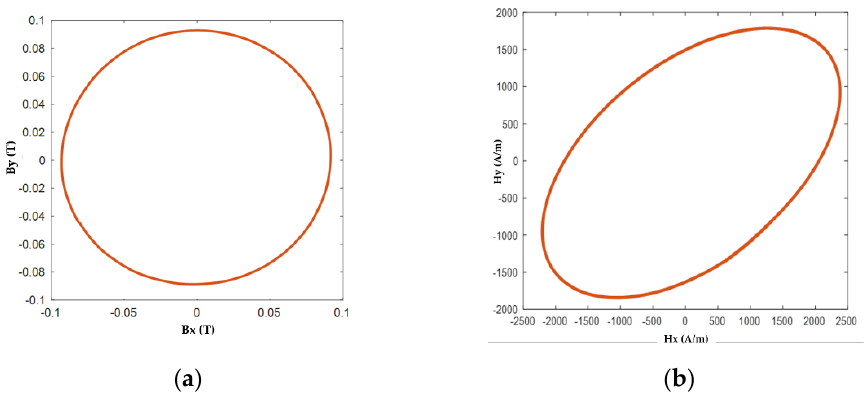
Figure 4. Loci of ( a ) B and ( b ) H at flux density of 90 mT and 50 Hz frequency .